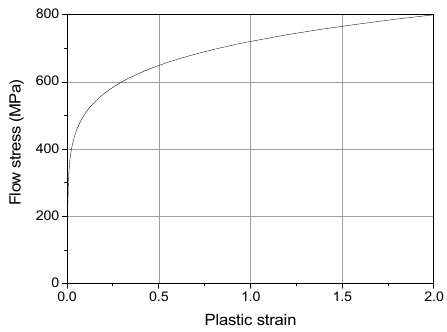
Figure 2. Flow stress of the D-ring and strap material.